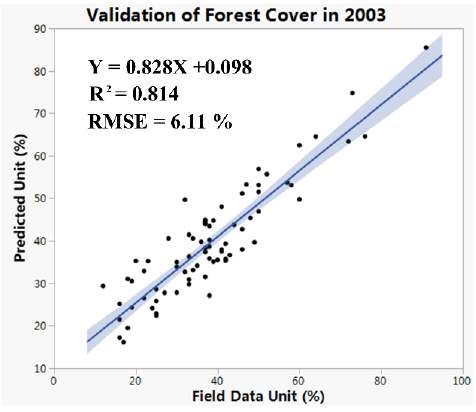
Figure 5. Scatterplot of predicted forest cover against field data in 2003.